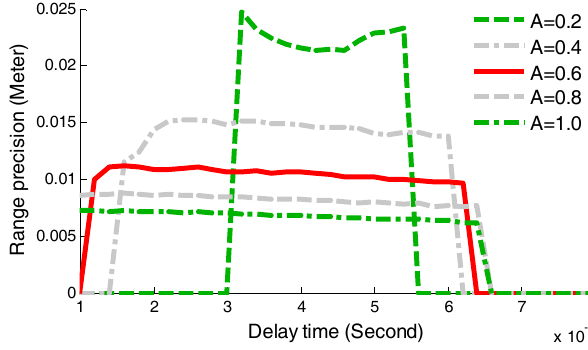
Figure 10. Comparison of DSstd varied with the different amplitudes.